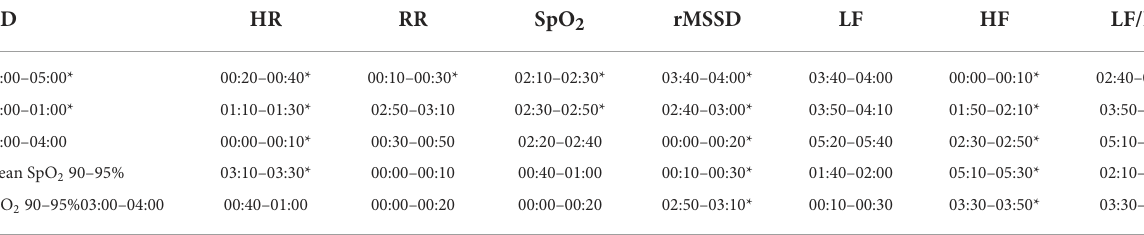
TABLE 7 The top five most important features of each feature group.